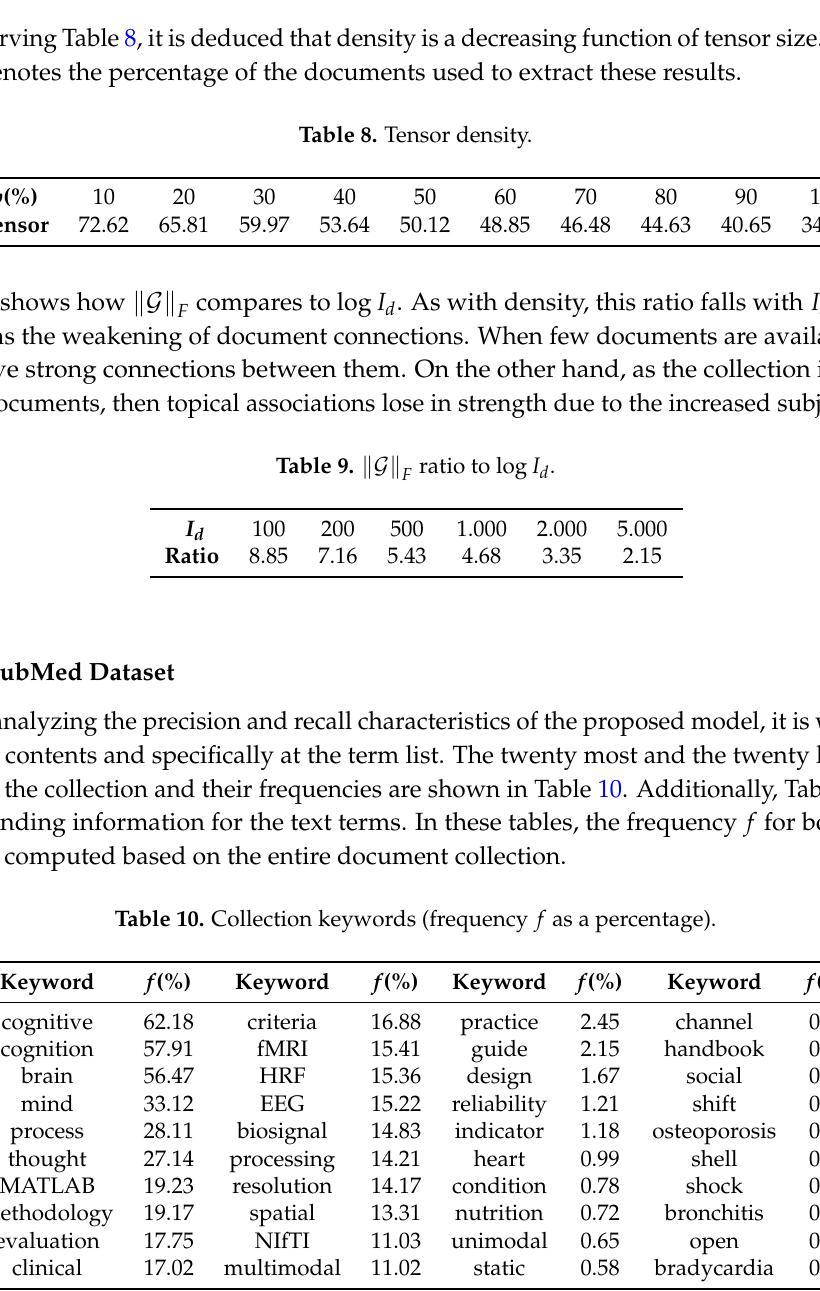
Table 8. Tensor density.